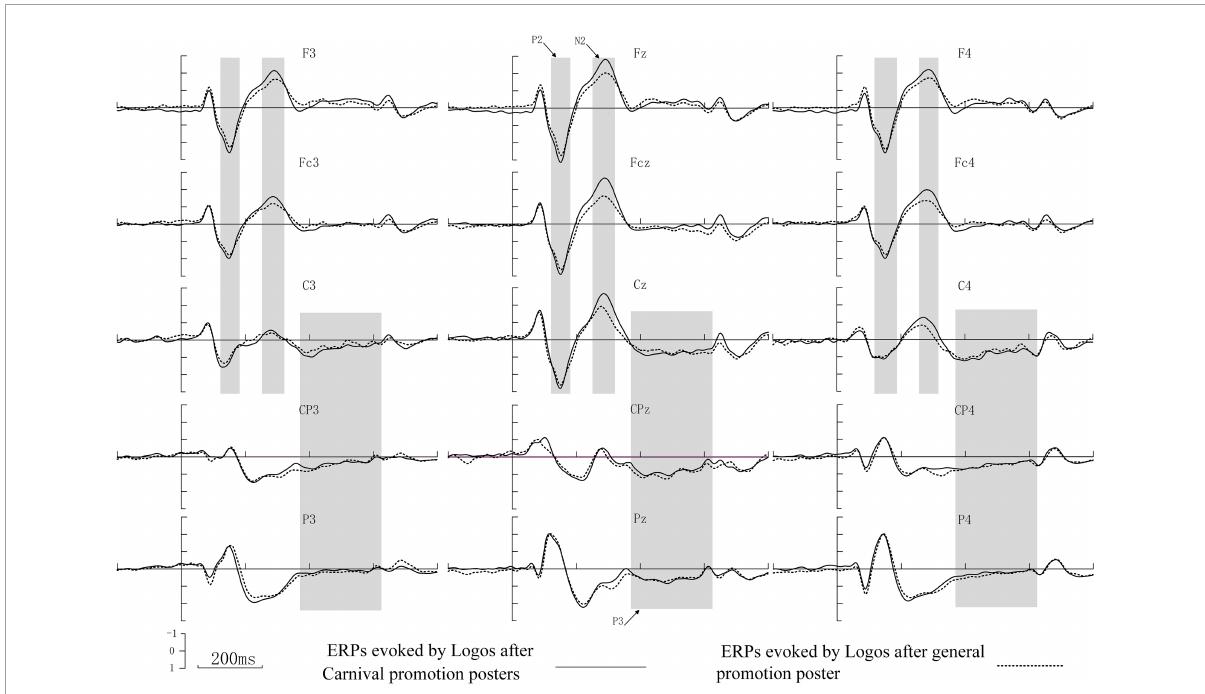
FIGURE2 Raw ERP waveforms at 15 electrode sites. Grand averaged ERP elicited by logos after carnival promotion posters (solid line) vs. logos after general promotion poster (dotted line) at 15 electrodes in the frontal, central, and parietal areas. Arrows indicate the P2 around 120–180 ms, N2 around 270–320 ms, and P3 around 370–630 ms. The ERP components P2 and N2 evoked by logo after carnival posters was stronger than after general promotion posters; however, the ERP component P3 evoked by logo after two promotion posters did not show significant